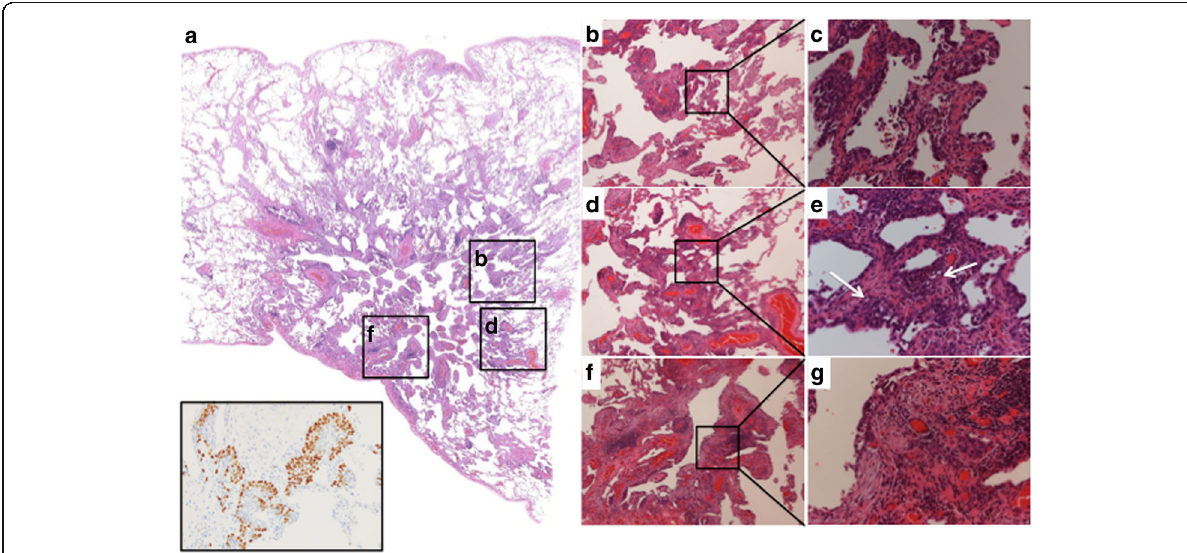
Fig. 2 Histopathological findings of the resected specimen. a The loupe image of the tumor. The inset shows an immunohistochemistry for p40 (×200), which was positive in the tumor cells. b A low-power view (×40) and c a high-power view (×200) of the area of carcinoma in situ. Tumor cells were spread along the alveolar wall. The basement membrane of the alveolar wall remained intact. d A low-power view (×40) and ( e ) a high-power view (×200) of the area in which carcinoma in situ and invasive carcinoma (arrows) coexisted. f A low-power view (×40) and g a high-power view (×200) of the area with invasive carcinoma. Stromal tumor cell invasion and stromal collagen fiber were observed. All the pictures are Hematoxylin and eosin stain except the immunohistochemical staining in the inset of